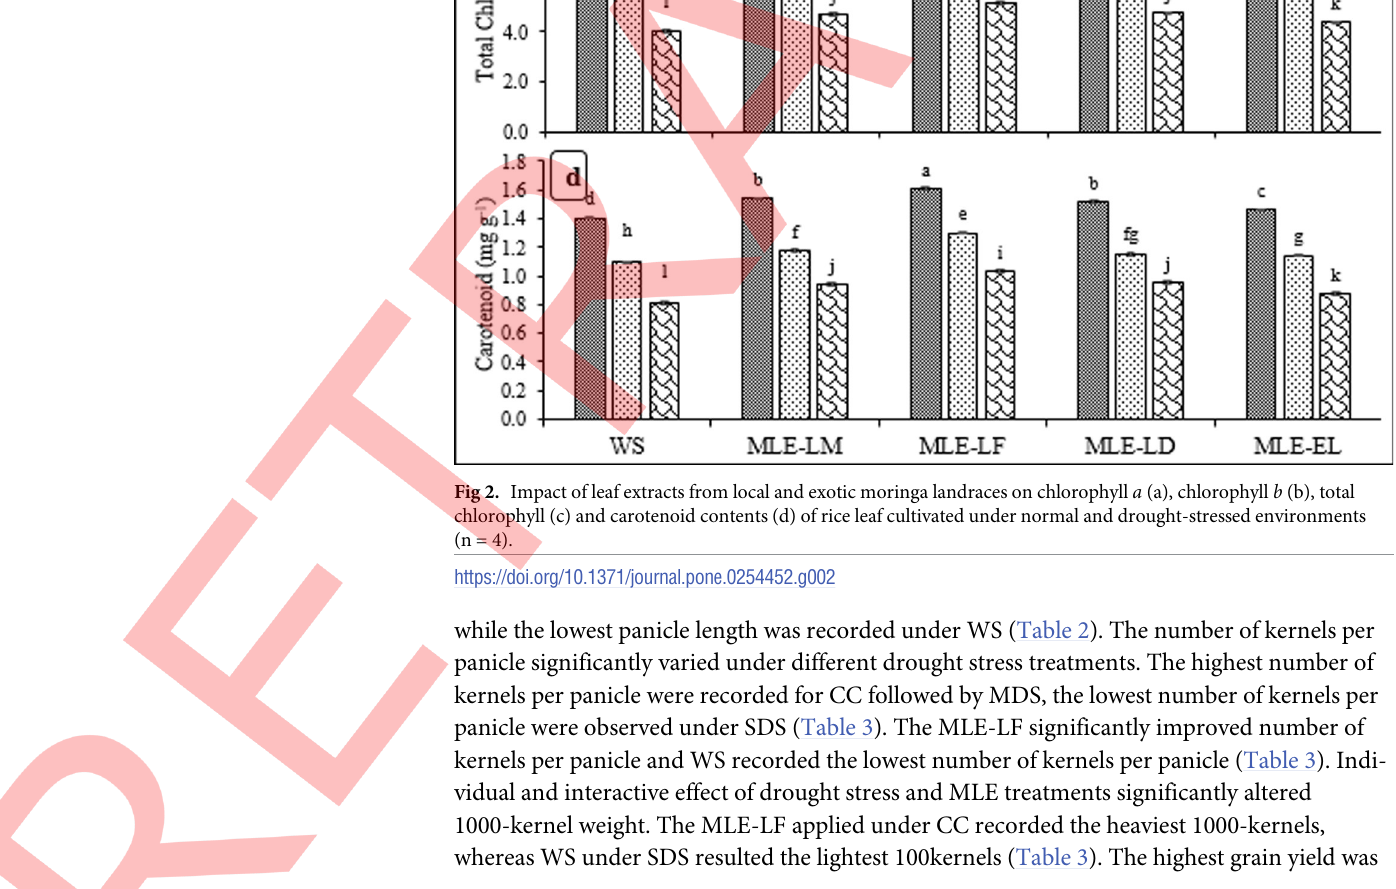
while the lowest panicle length was recorded under WS (Table 2). The number of kernels per panicle significantly varied under different drought stress treatments. The highest number of kernels per panicle were recorded for CC followed by MDS, the lowest number of kernels per panicle were observed under SDS (Table 3). The MLE-LF significantly improved number of kernels per panicle and WS recorded the lowest number of kernels per panicle (Table 3). Indi- vidual and interactive effect of drought stress and MLE treatments significantly altered 1000-kernel weight. The MLE-LF applied under CC recorded the heaviest 1000-kernels, whereas WS under SDS resulted the lightest 100kernels (Table 3). The highest grain yield was